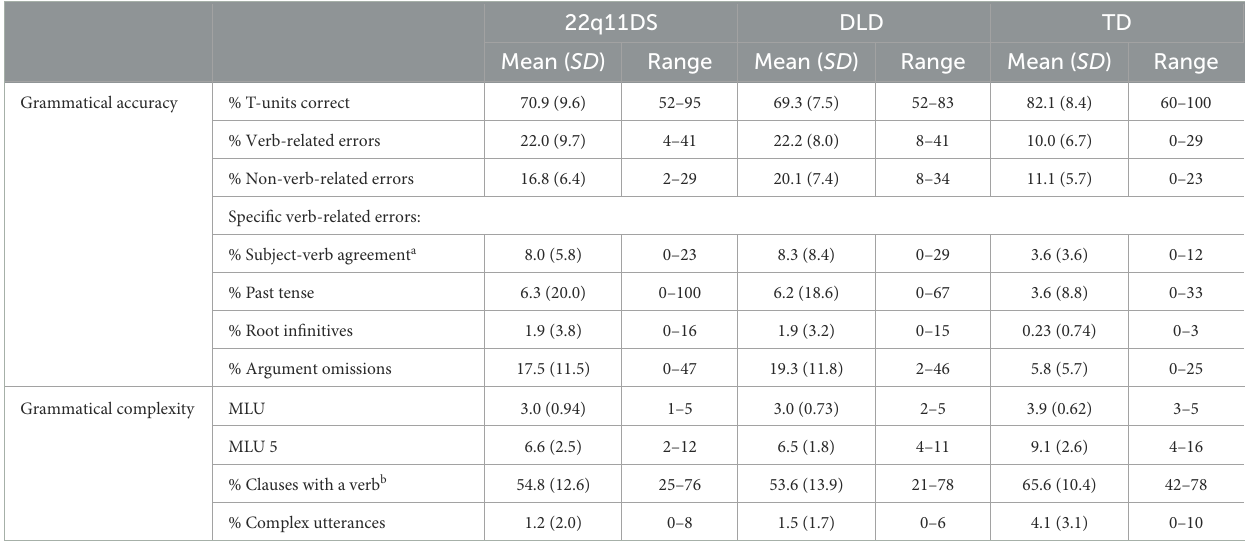
TABLE 4 Outcomes of the three groups of preschool children on the spontaneous language